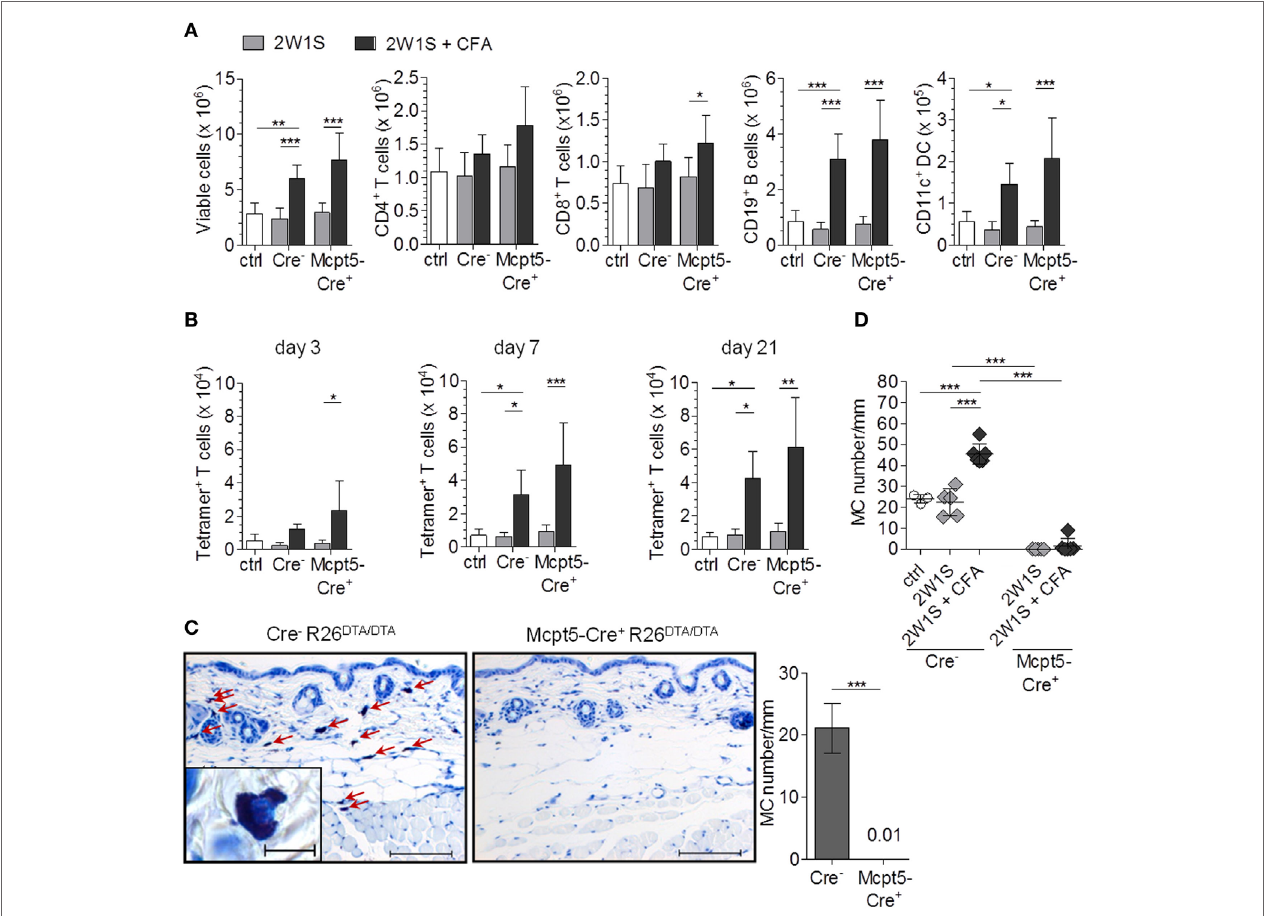
FigUre 2 | The antigen-specific T cell response is not diminished in mast cell (MC)-deficient mice. (a) Mcpt5-Cre + R26 DTA/DTA mice and Cre -negative littermates were immunized with 2W1S peptide alone or peptide plus CFA by intradermal injection at the tail base (2W1S: n = 5 both groups; 2W1S/CFA: Cre − n = 11/ Cre + n = 12) and lymph node cellularity was assessed 3 days (see Figure S2 in Supplementary Material), 7 days, and 21 days (see Figure S2 in Supplementary Material) later. Saline-injected Cre -negative littermates served as additional controls. (B) Numbers of 2W1S-specific T cells in the LNs from A [time points as in (a) ] were quantified by MHC II tetramer staining. (c,D) Efficient MC depletion of the dermal immunization site at the tail base was verified by histological analysis of Giemsa-stained skin sections in untreated mice (c) and at day 21 after immunization (D) (scale bar 100 µm, inset 10 µm). Dermal MCs were counted per 20-mm length of epidermis for each mouse. N = 7 per group at day 0; n = 4 Cre -negative saline controls, n = 5 2W1S both groups; n = 9 Cre − / n = 8 Cre + 2W1S/CFA at day 21; means ± SD are shown. Data were collected from at least four independent experiments per time point. Statistical analysis was performed using one-way ANOVA and